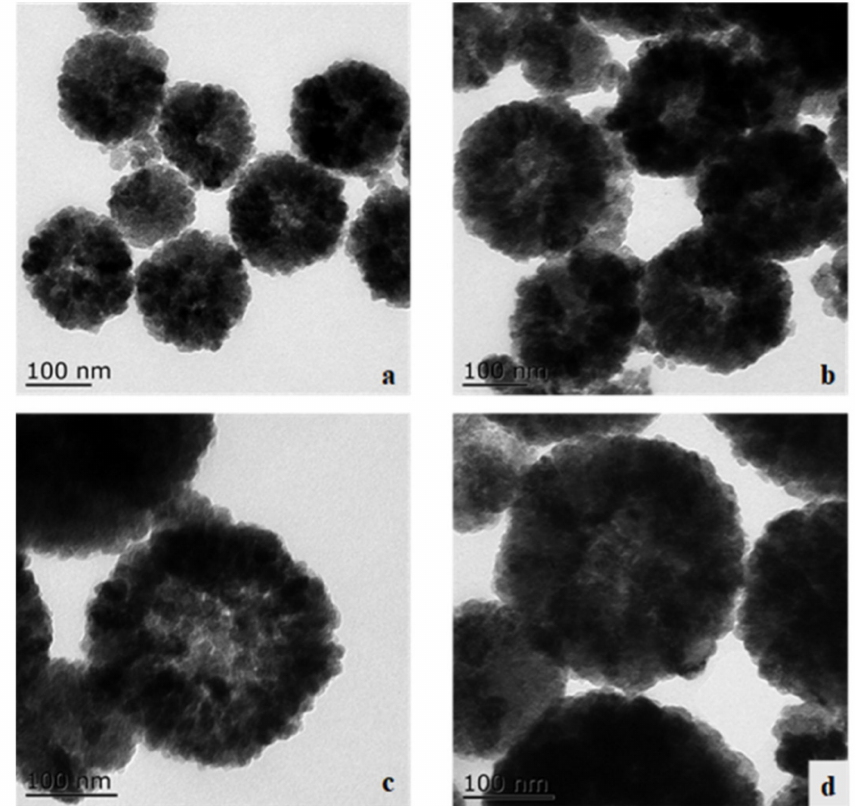
Figure 1. TEM images of CuFe 2 O 4 /MgFe 2 O 4 : ( a ) Cu:Mg = 1:0.5; ( b ) Cu:Mg = 1:1; ( c ) Cu:Mg = 1:2; ( d ) Cu:Mg =